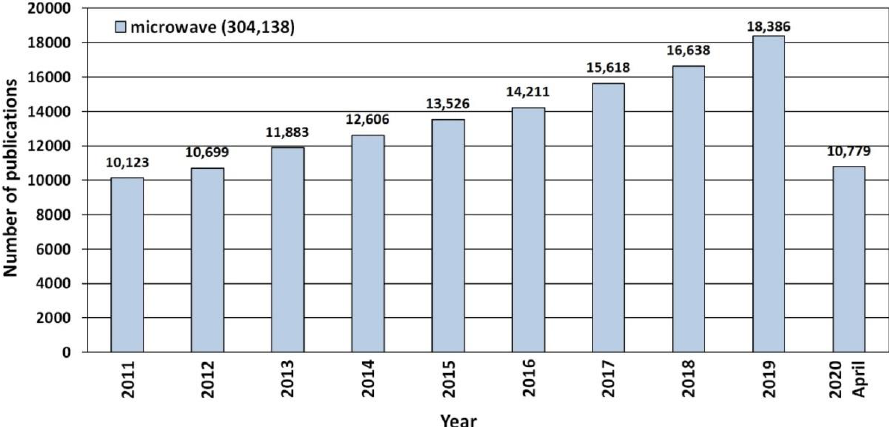
Figure 13. The number of scientific publications referring to the search of “microwave” phrases published in the period of 2011–2020. Source: ScienceDirect (accessed on 19th April 2020).